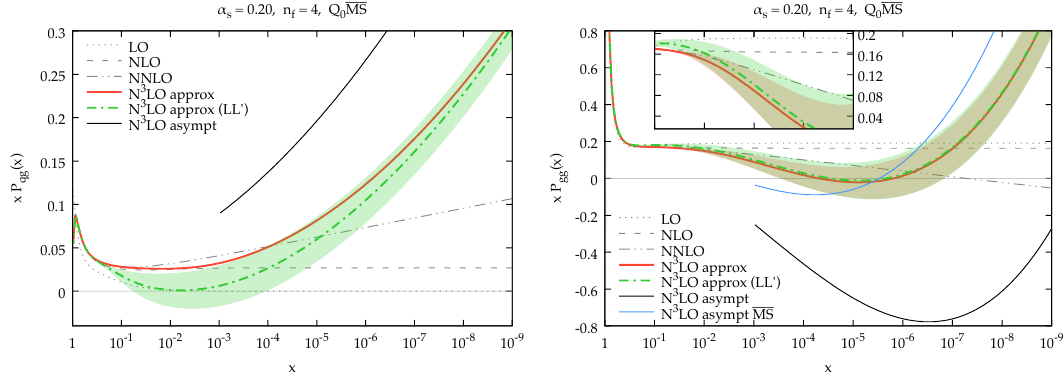
Figure 4 . Approximate N 3 LO prediction (solid) of the P qg (left) and P gg (right) splitting functions as obtained by the O ( (cid:11) 4 ) expansion of the resummation. The NLL asymptotic behaviour is also s shown (light